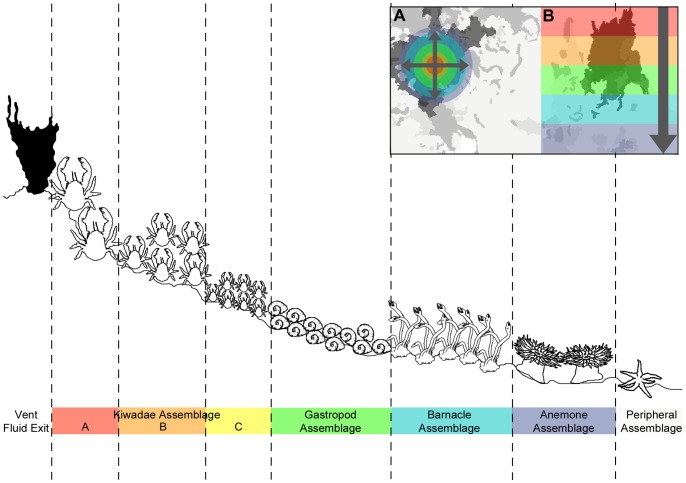
Idealised schematic of the spatial distribution of the E9 vent field faunal assemblages with increasing distance from a vent fluid exit.This spatial pattern of zonation radiates in both (A) horizontal and (B) vertical directions.